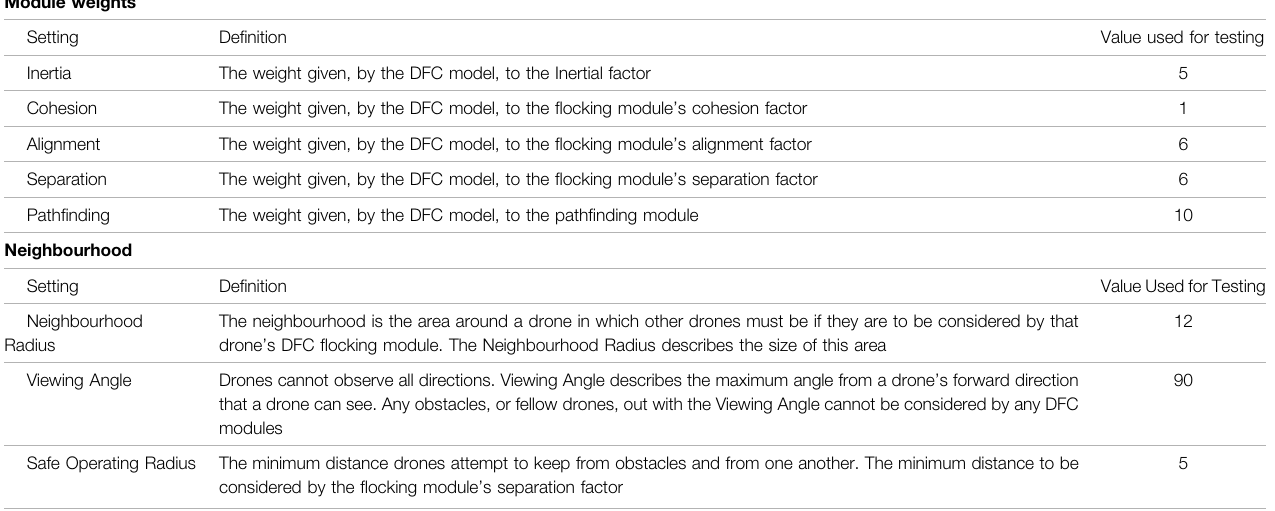
TABLE 3 | Drone Settings values selected for